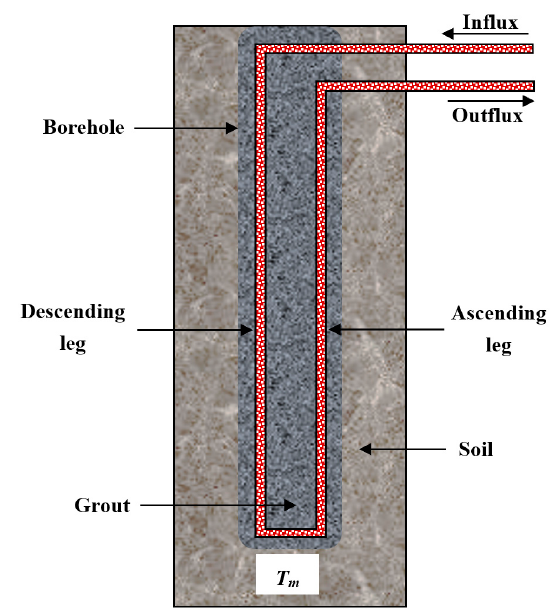
Figure 1. Schematic of a borehole GHE with a single U-shape tube.